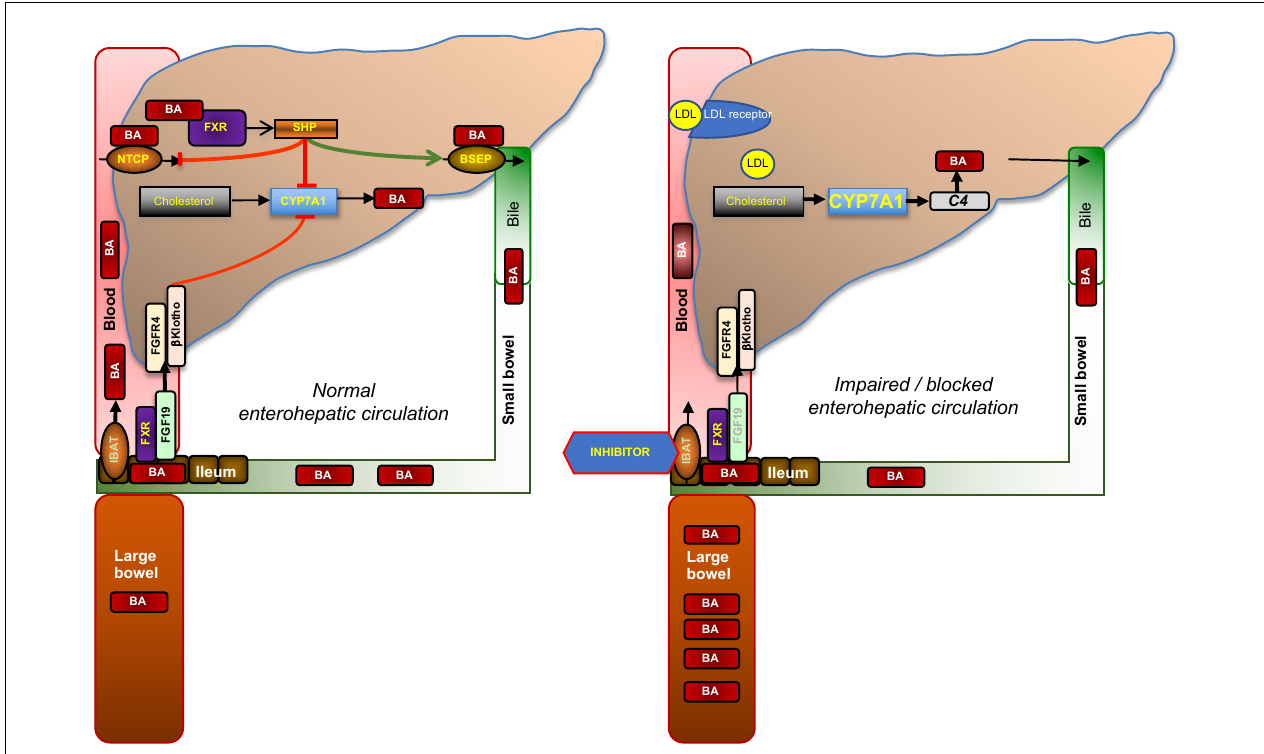
FIGURE 2 | Enterohepatic circulation of bile acids and mode of action of ileal bile acid transporter (IBAT) inhibitors. Glycine- or taurine- conjugated BAs are excreted via the bile salt export pump (BSEP) into bile in which they reach the duodenum. About 95% of conjugated BAs are reabsorbed in the terminal ileum via the apical sodium-dependent BA transporter (ASBT, SLC10A2 ; also known as IBAT, ileal BA transporter) and recirculated to the liver via the portal vein from which they are reabsorbed via the sodium-dependent taurocholate co-transporting peptide (NTCP, SLC10A1 ). This recycling process is called enterohepatic circulation. The rate-limiting enzyme of BA synthesis from cholesterol, CYP7A1, is controlled by two different negative feed-back pathways that are both regulated by binding of BAs to its nuclear receptor, FXR: (1) within the liver, when BA exceed physiological levels as in cholestasis, via small heterodimer partner (SHP) that signals to reduced expression of CYP7A1 and NTCP, and increased expression of BSEP; and (2) from the ileum via increased formation of fibroblast growth factor 19 (FGF19, FGF15 in rodents), which circulates to the liver in portal blood, binds to the heterodimer FGF4-receptor/ β -klotho, and triggers a signaling cascade to inhibit CYP7A1. When ileal reuptake of BAs is functionally impaired as in BA malabsorption syndrome or pharmacologically blocked with an IBAT inhibitor (right part of figure), BAs decrease and fecal BA excretion increases which may cause BA malabsorptive diarrhea. Decreased BA activation of ileal FXR results in reduced formation of FGF19 and diminished feed-back inhibition of BA synthesis. Increased BA synthesis via CYP7A1, reflected by increased serum C4, depletes the liver from cholesterol, which is compensated by increased cholesterol synthesis and the enhanced expression of low-density lipoprotein receptor (LDLR), which results in decreased serum LDL